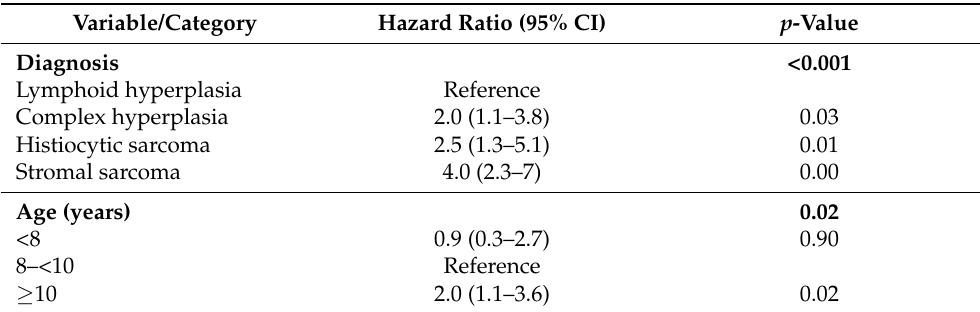
Table 5. Results from Cox proportional hazard model estimating the associations between type of splenic fibrohistiocytic nodule, age, sex, and breed on survival of dogs identified from the VetCompass Australia database that attended primary-care veterinary clinics during 1989–2018 in